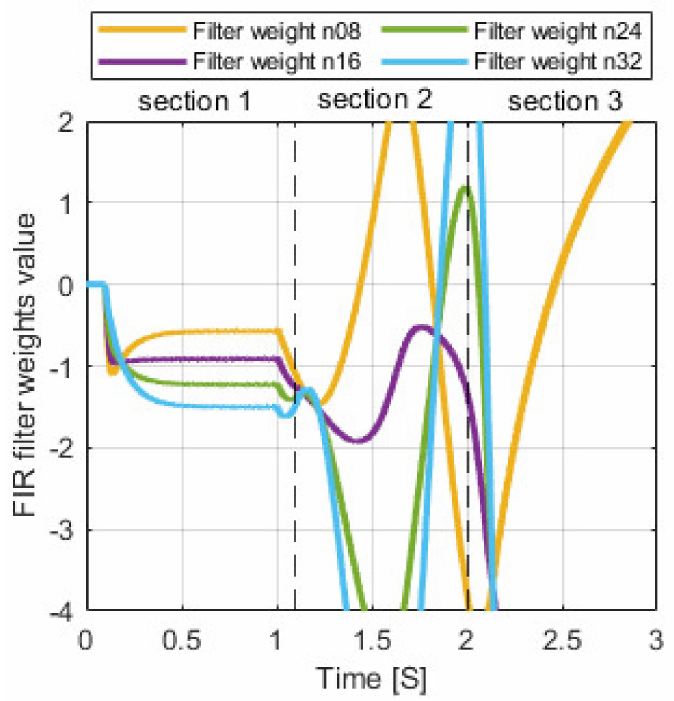
Figure 28. Simulation cycle 2: weight trend in FIR discrete